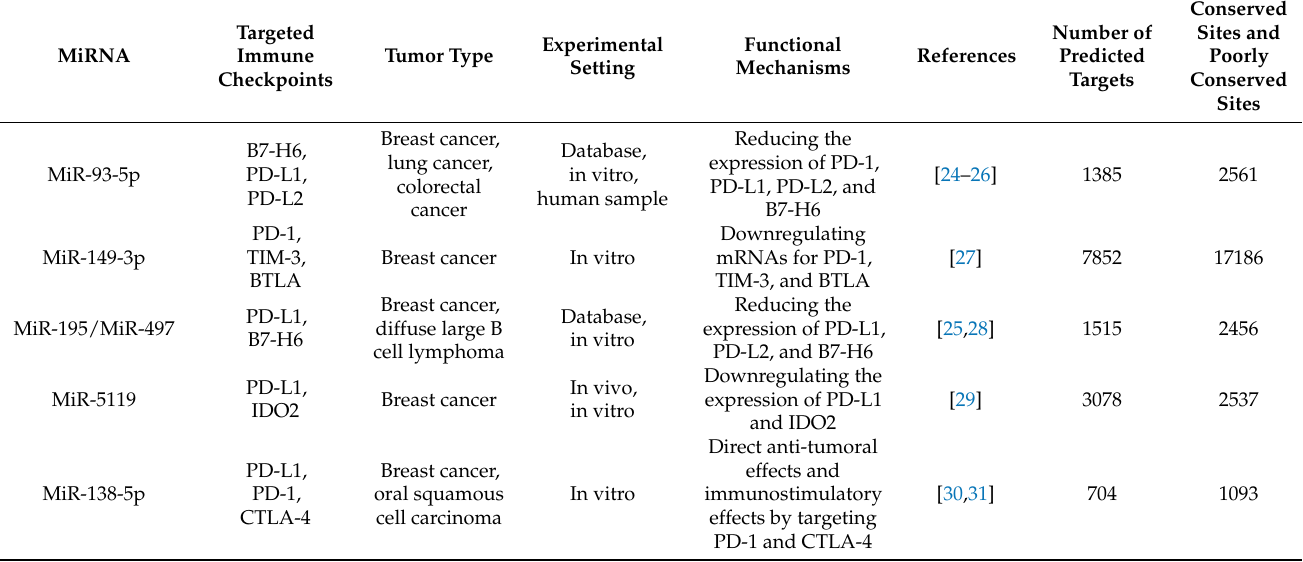
Table 1. Studies of selected miRNAs targeting multiple immune checkpoints and the total number of potential targets of selected